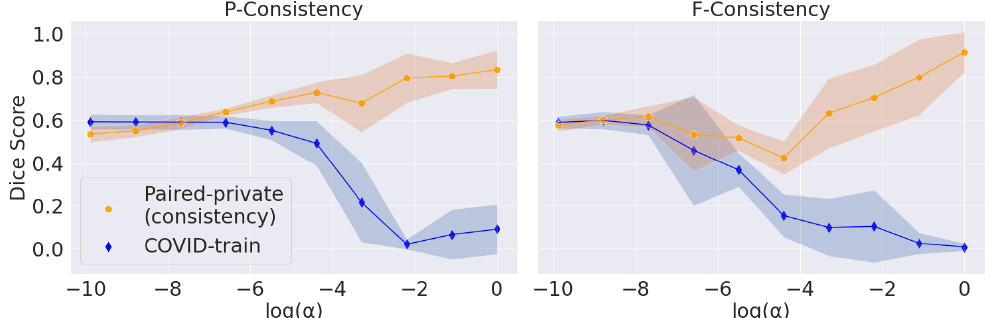
Figure 4. Trade-off between the segmentation quality and consistency scores induced by the reg- ularization parameter α (Section 2.4). The blue line corresponds to Dice Scores calculated on the COVID-train dataset. The orange line corresponds to the consistency scores calculated on the Paired- private dataset. The shaded areas correspond to the standard deviation along the